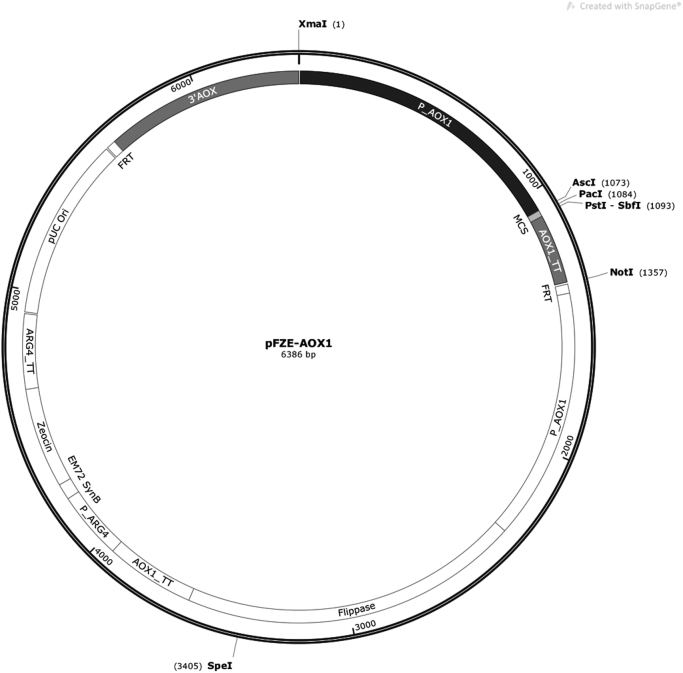
Map of plasmid pFZE-AOX1.